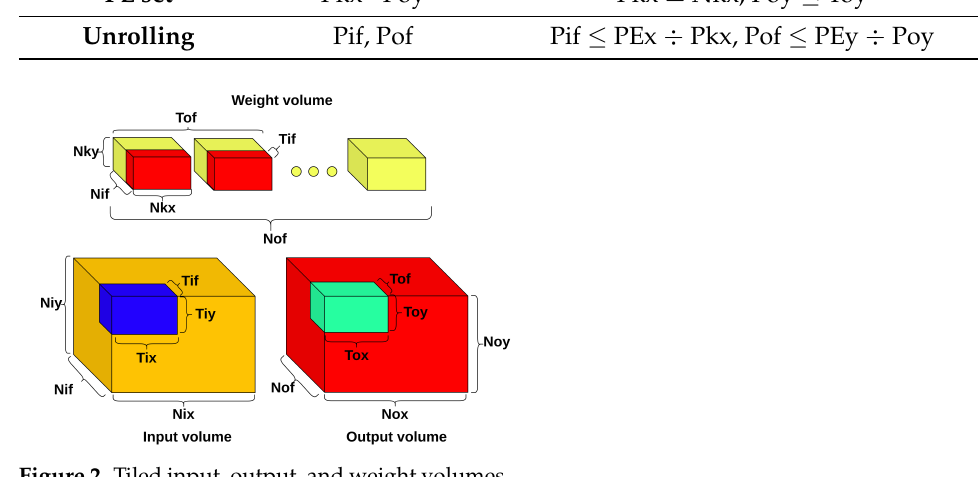
Figure 2. Tiled input, output, and weight volumes.